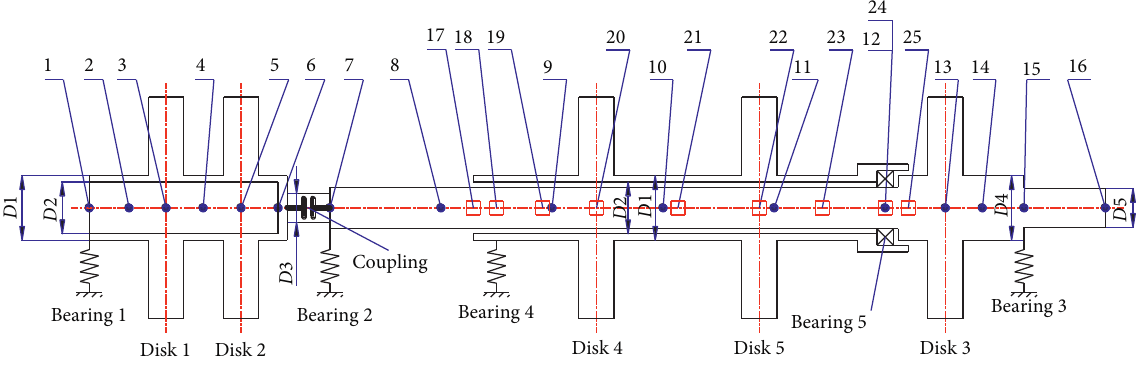
Figure 2: Schematic of the dual-rotor system, nodes, and elements.